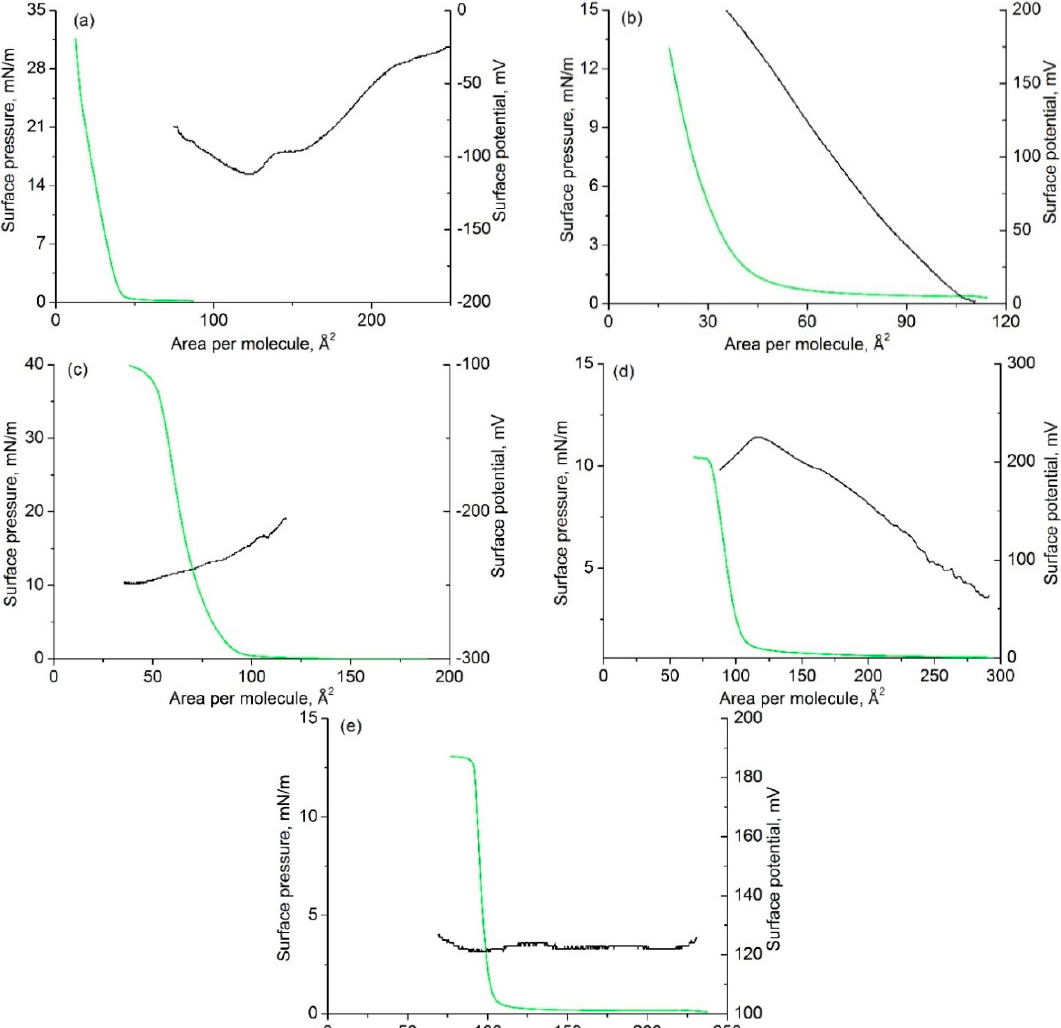
Figure 6. Surface pressure-molecular area (green lines) and surface potential-molecular area isotherms (black lines), at air–water interface ( C = 2 × 10 − 5 M in CHCl 3 ), of chromophores ( a ) 1 ; ( b ) 4 ; ( c ) 3 ; ( d ) 5 ; ( e ) 8 .